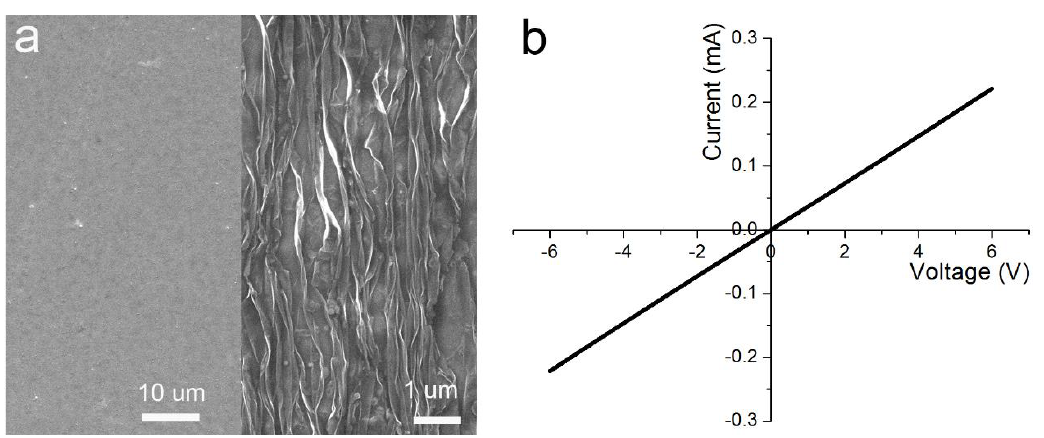
Figure 2. The interface characteristics of the graphene / crumpled graphene (CG). ( a ) The SEM pictures of the graphene and CG. ( b ) I–V curve of the graphene / CG junction.